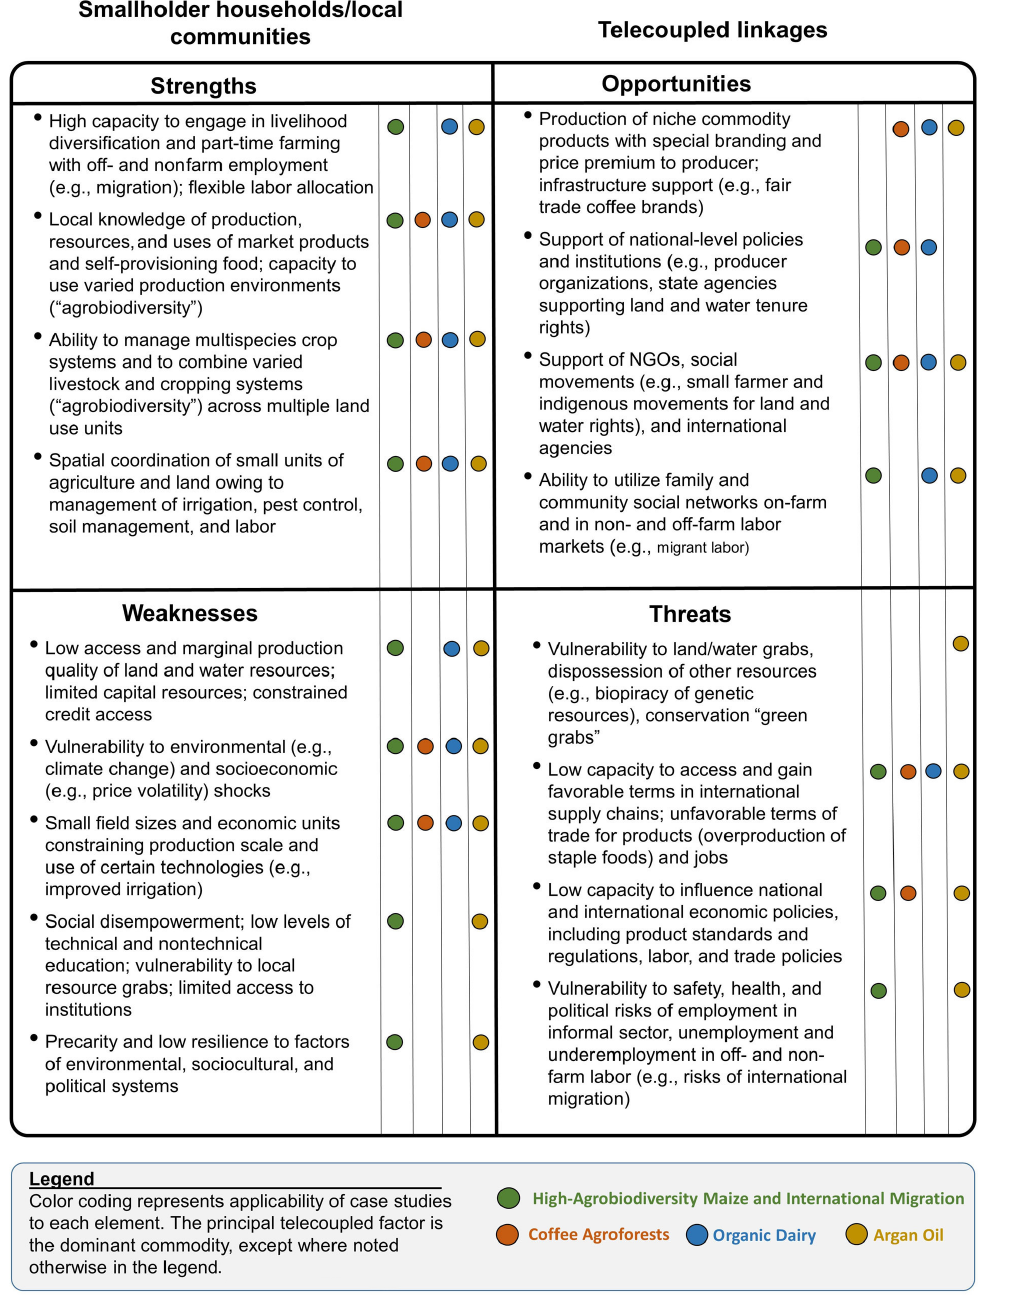
Fig. 4 . Predominant characteristics of the telecoupling of smallholder social-ecological systems with potential contributions to